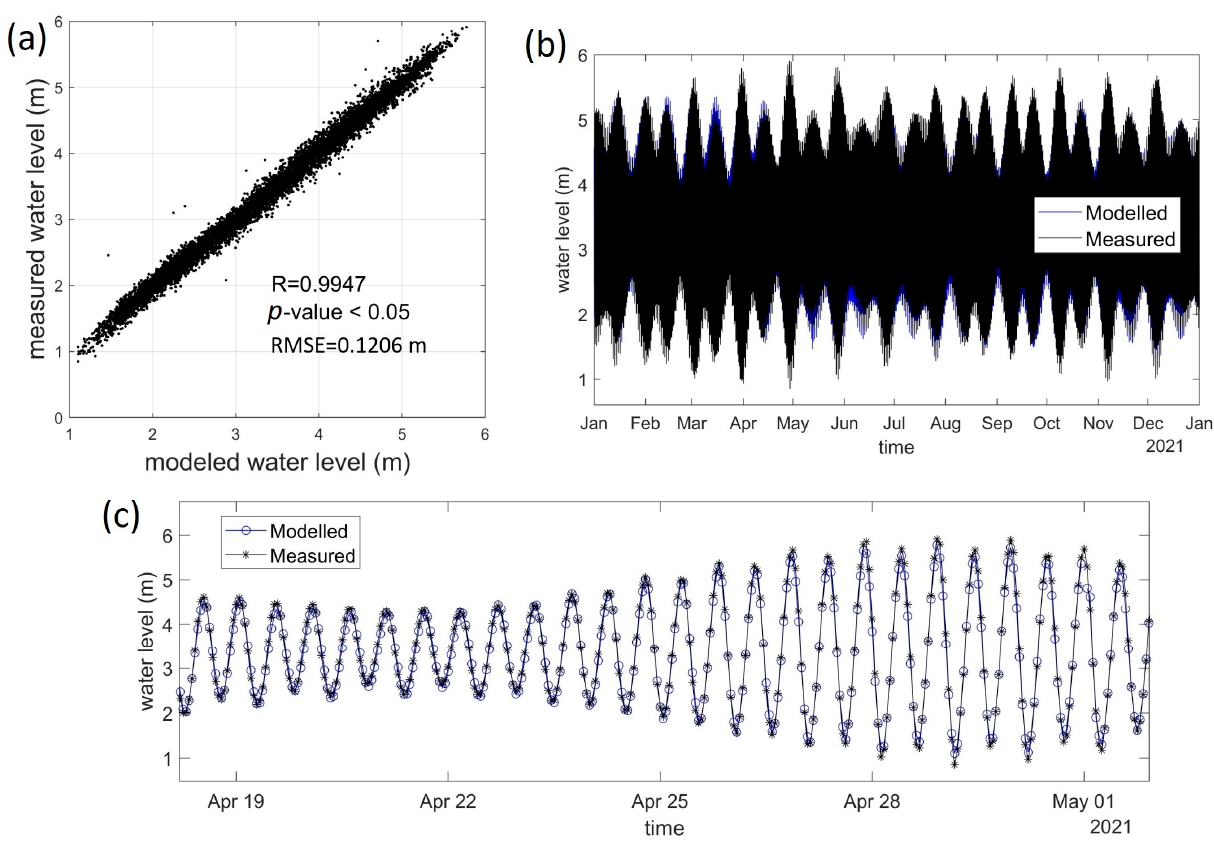
Figure 2. Model calibration results of water level data: ( a ) diagram dispersion modeled vs. measured, ( b ) hourly 1-year (2021) time series comparison, ( c ) zoom-in of time series comparison.